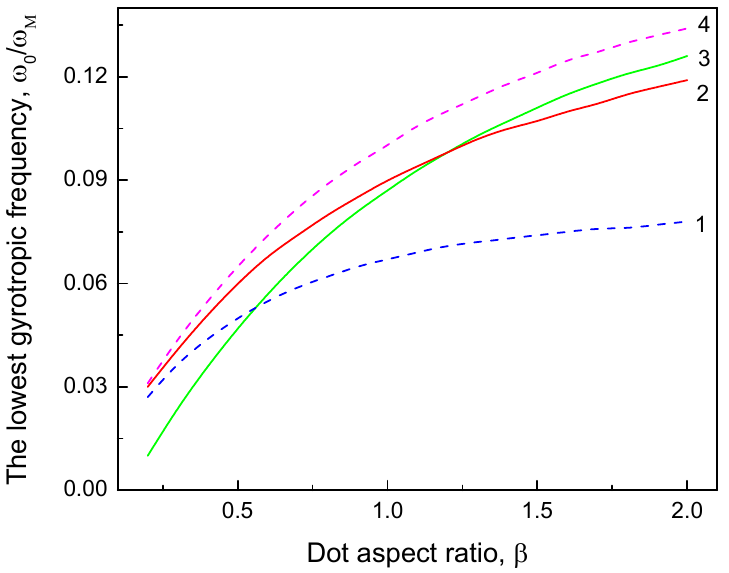
Figure 1. The lowest vortex gyrofrequency (solid line 3) calculated using Equation (12a). The dashed lines 1 and 4 describe the limiting frequencies corresponding to the frequency window I ( 1/2, β ) < ω ( β ) / ω < I ( 0, β ) of the mode localization between the turning points. The frequency (solid line 2) is the gyrotropic frequency calculated in [8] assuming the gyromode uniformity along the dot thickness extrapolated for large values of β . The reduced dot radius r = R / L e = 10 .